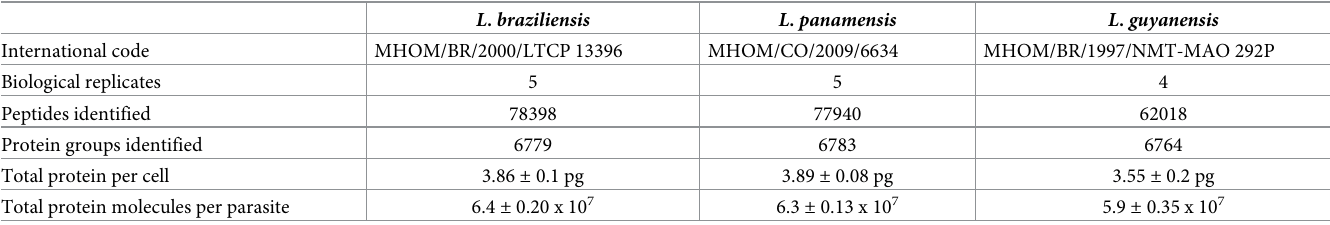
Table 1. Summary of general information about the proteomes of Leishmania braziliensis , L . panamensis and L . guyanensis